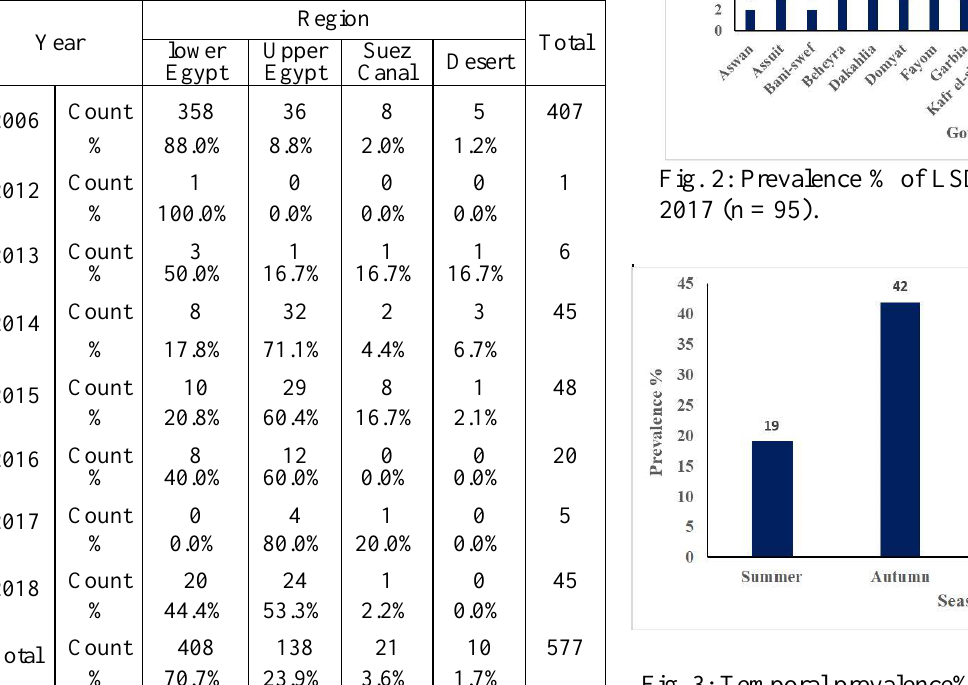
Table 1: Spatial Distribution of LSD in Egypt (4 regions) during 2006 -2018